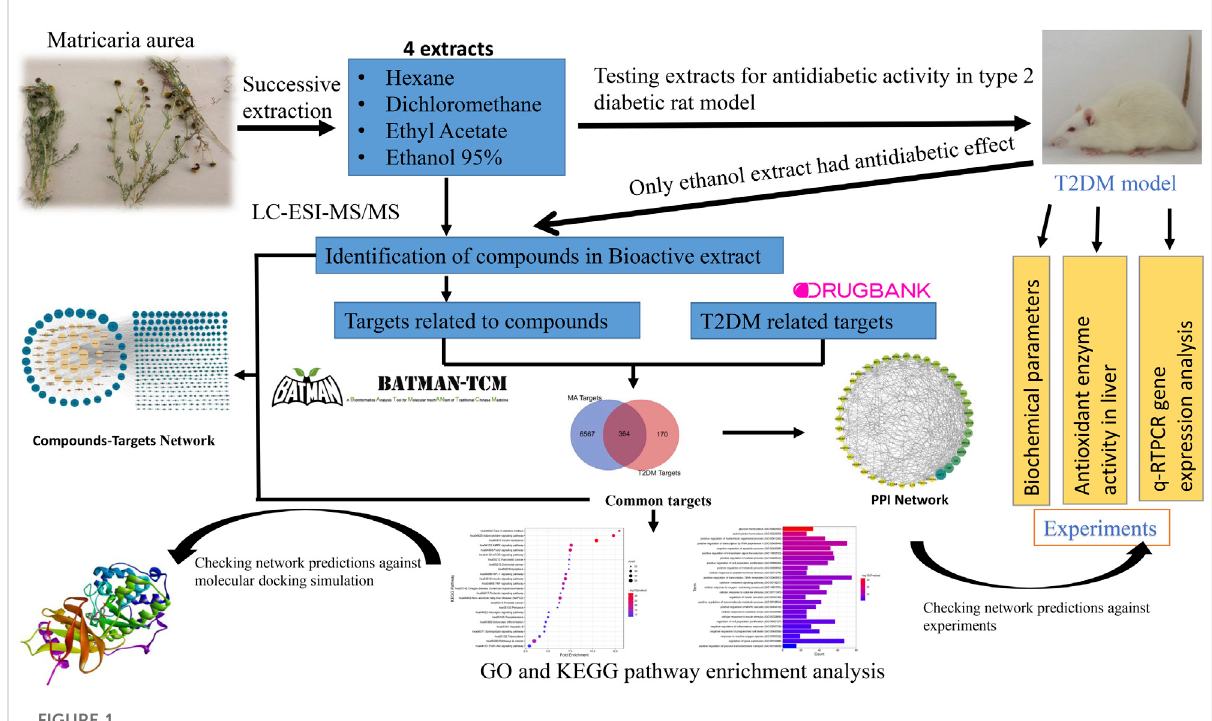
FIGURE 1 Graphical abstract. Adjusting the size of the images, resolution, and combining the images was carried out using